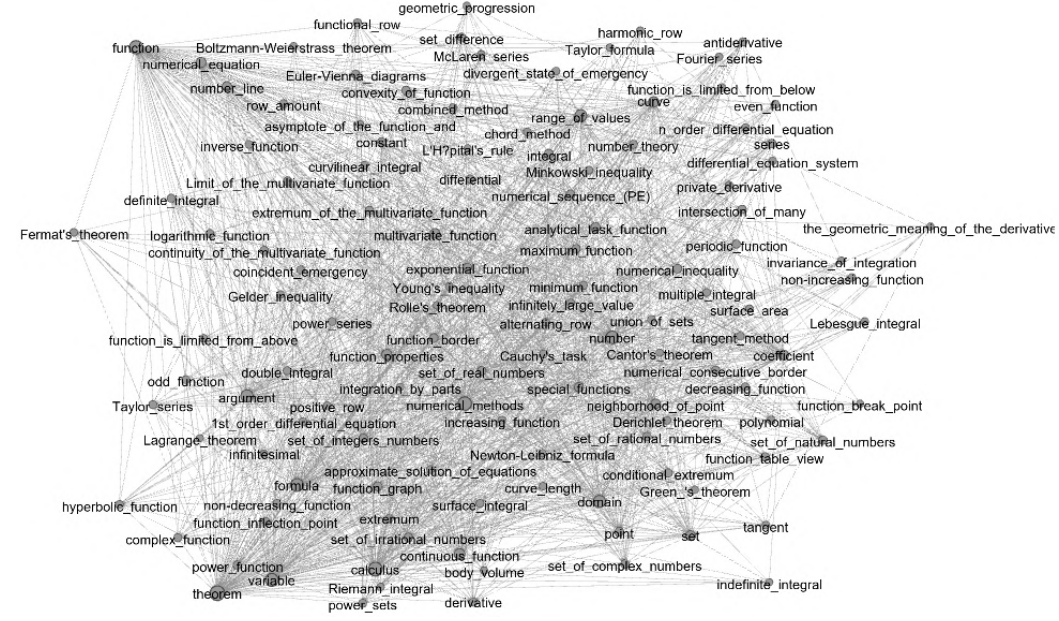
Figure 3: Presentation of paper